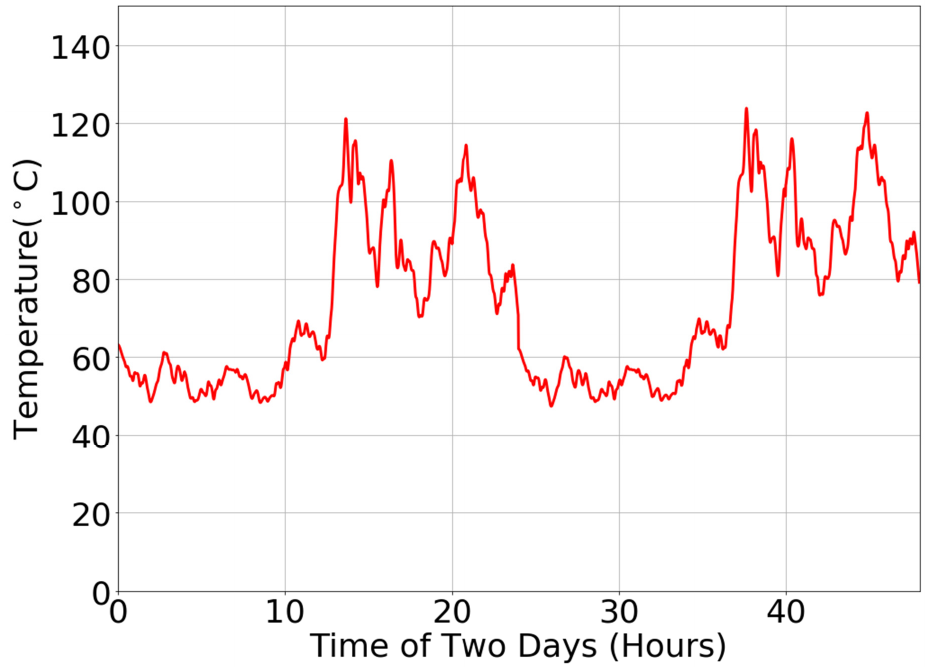
Figure 10. Path tracking response of the straight line: spatial representation ( a ) and its contour error ( b ).